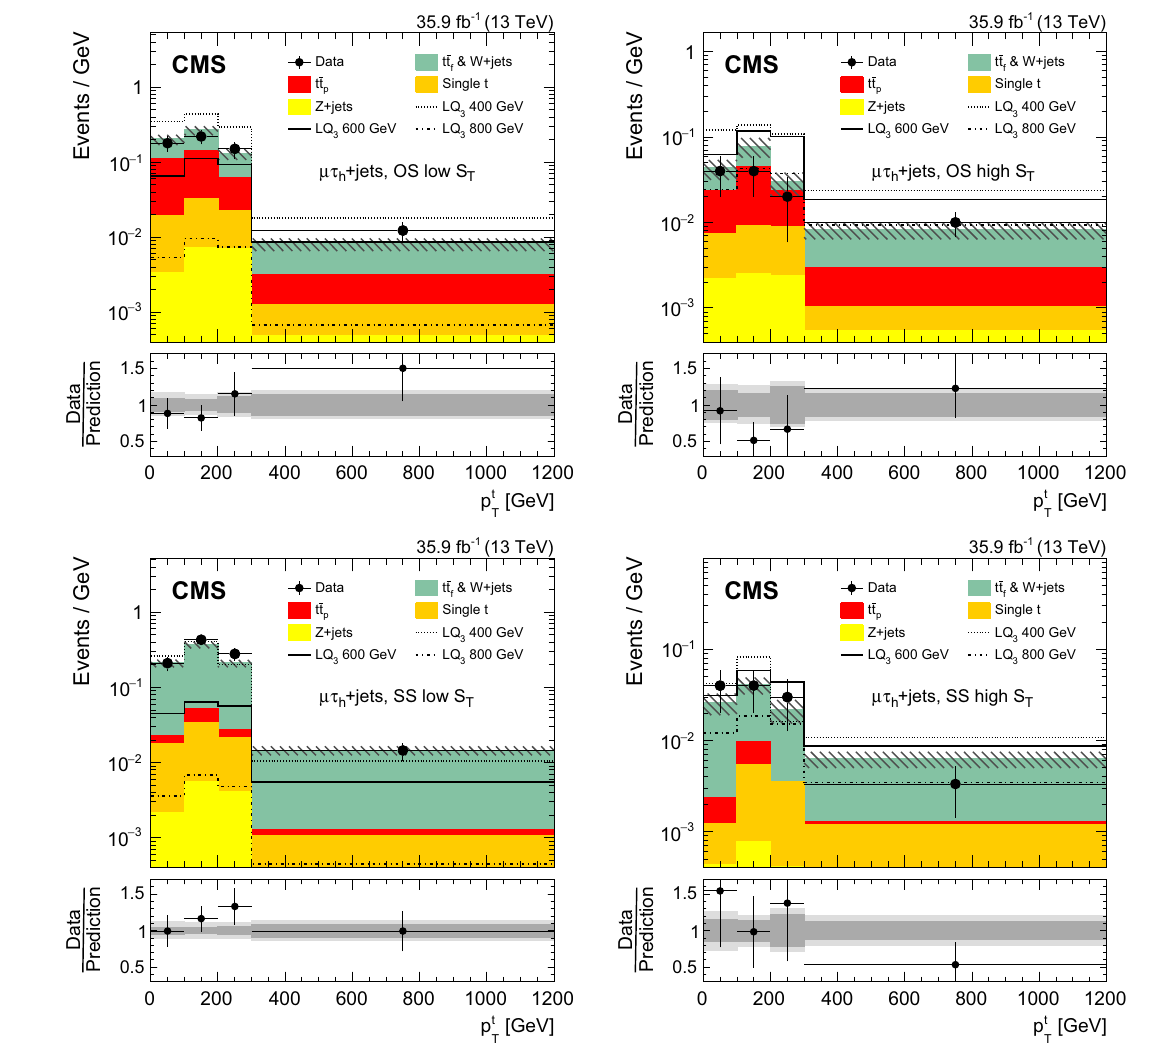
Fig. 5 Distributions of p t for events in the muon channel passing the T full selection in category A. The events are separated into OS (upper), SS (lower), low S T (left) and high S T (right) categories. The hatched areas represent the total uncertainties of the SM background. In the bot-